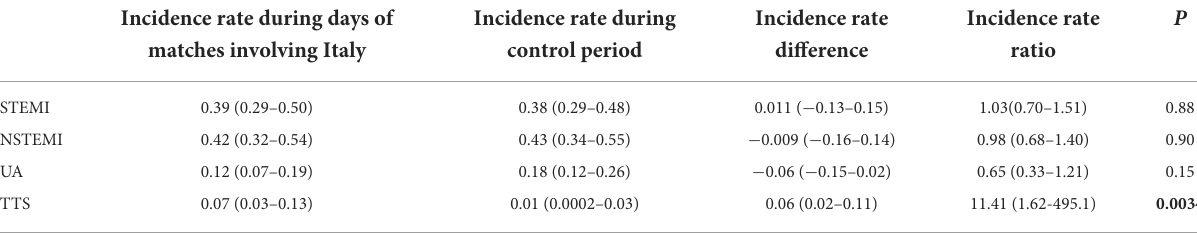
TABLE 2B Incidence of ACE on semifinal and final matches, as compared with days during the control period. Incidence rate during days of matches involving Italy